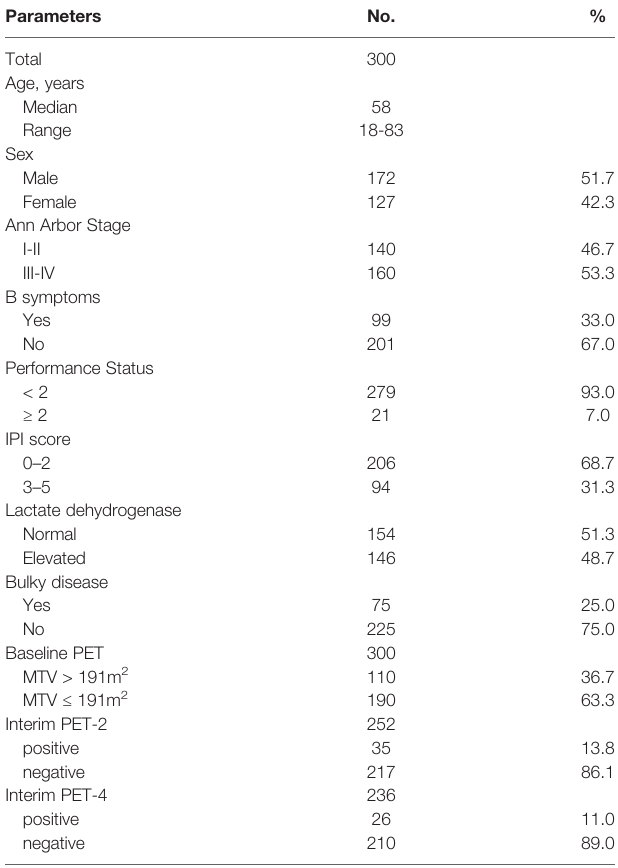
TABLE 1 | Clinical features of patients with diffuse large B-cell